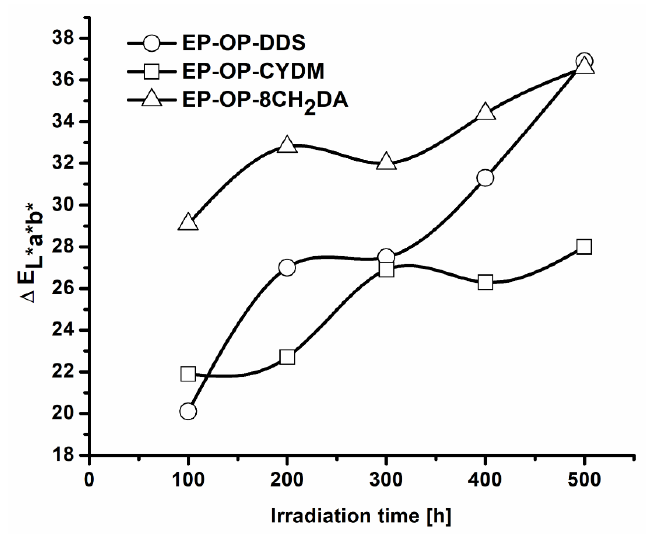
Figure 5. Color differences variation with exposure